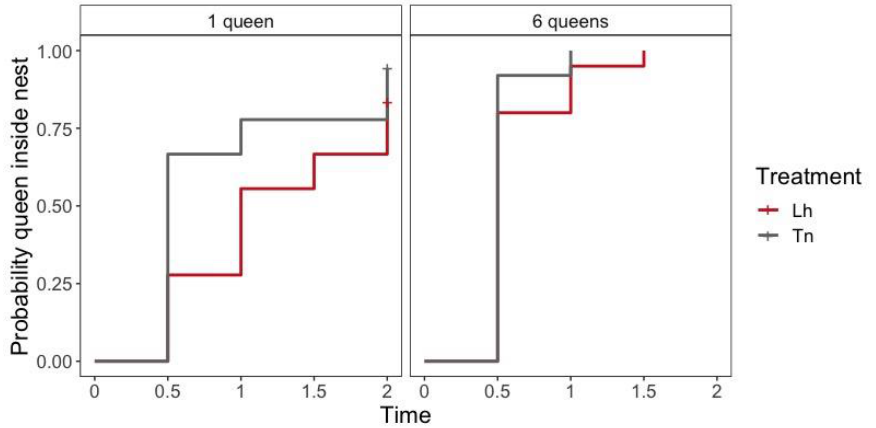
Figure 1. Kaplan–Meier plot of time (in hours) for first queen to enter the nest shows the survivor function stratified according to the number of queens and species. Plus signs (+) indicate censored data and their corresponding x values for the time at which censoring occurred. Lh = L. humile nest and Tn = T. nigerrimum nest.